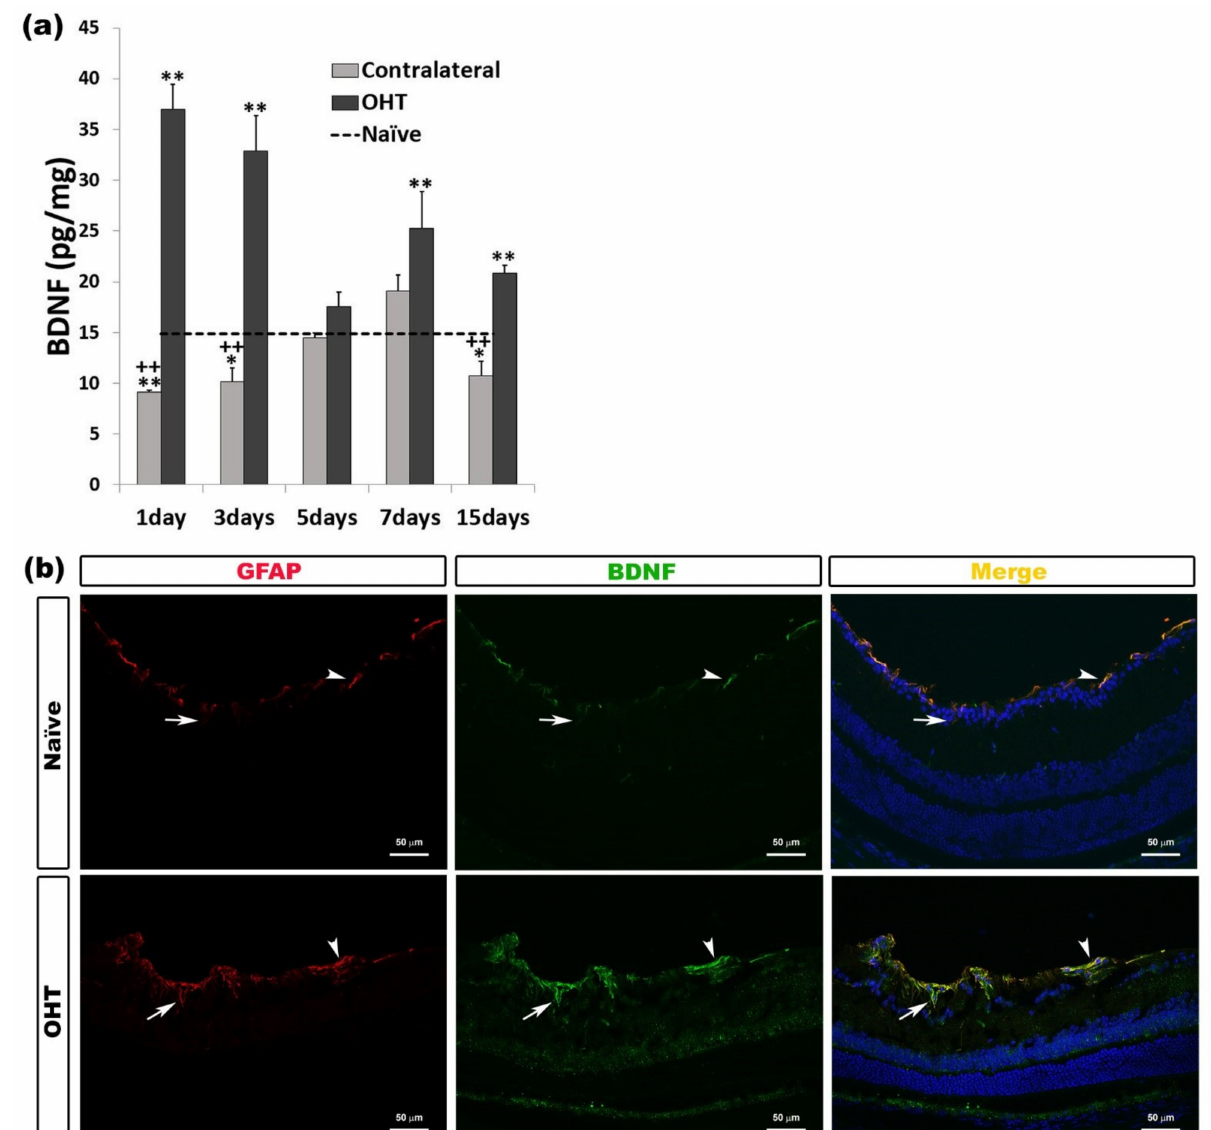
Figure 9. Brain-Derived Neurotrophic Factor (BDNF) levels at different times after laser-induced ocular hypertension (OHT). ( a ) The variation over time in the BDNF levels in the multiplex assay. The histogram shows the mean levels ( ± SD) of BDNF (pg/mg) at days 1, 3, 5, 7, and 15 after laser OHT induction, in ocular hypertension eyes (OHT) and in contralateral eyes. The dashed line indicates the mean levels in naïve eyes. Statistical significance indicators: * p < 0.05, ** p < 0.01 vs. naïve; ++ p < 0.01 vs. OHT. ( b ) Immunohistochemical study of BDNF expression in OHT eyes one day after unilateral laser-induced OHT. Retinal sections were immunolabeled with antibodies to BDNF (green) and GFAP (red). Merge (yellow). The arrowheads (astrocytes) and arrows (Müller cells) indicate the co-expression of GFAP and BDNF, with the expression being more intense in OHT than in naïve eyes. Abbreviations: OHT (ocular hypertension); BDNF (brain-derived neurotrophic factor); GFAP (glial fibrillary acidic